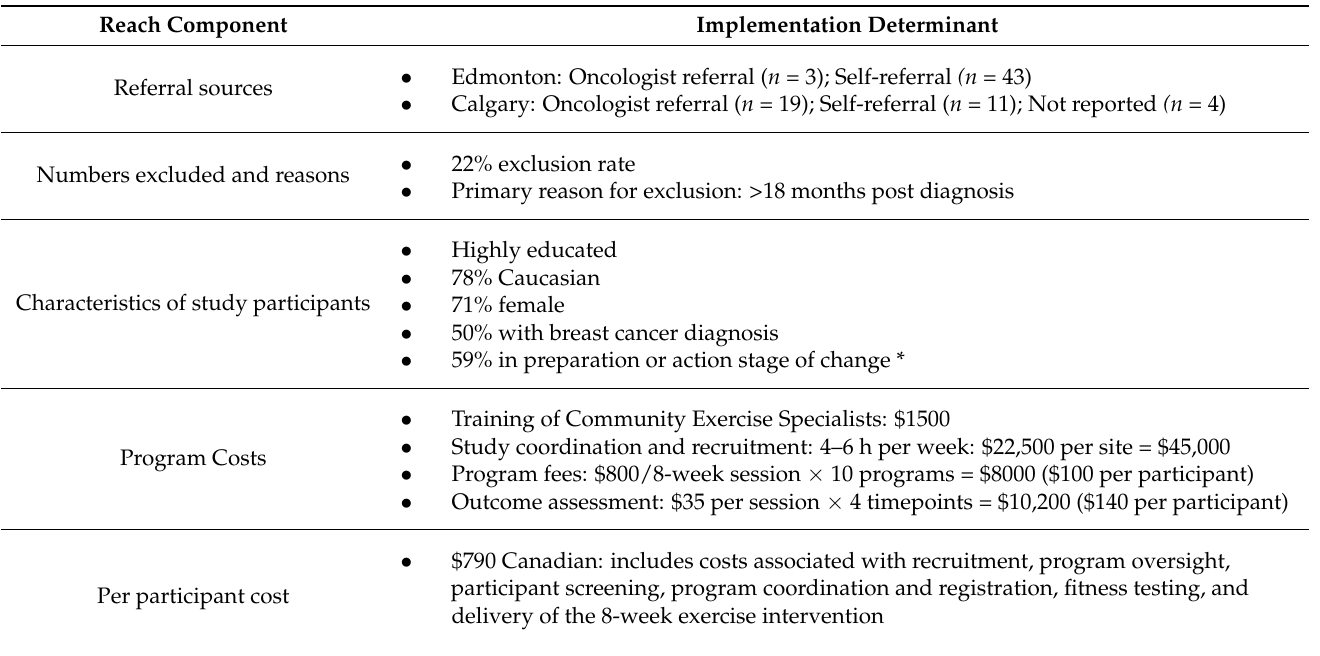
Table 3. Table 3. Evaluation of Processes: Program